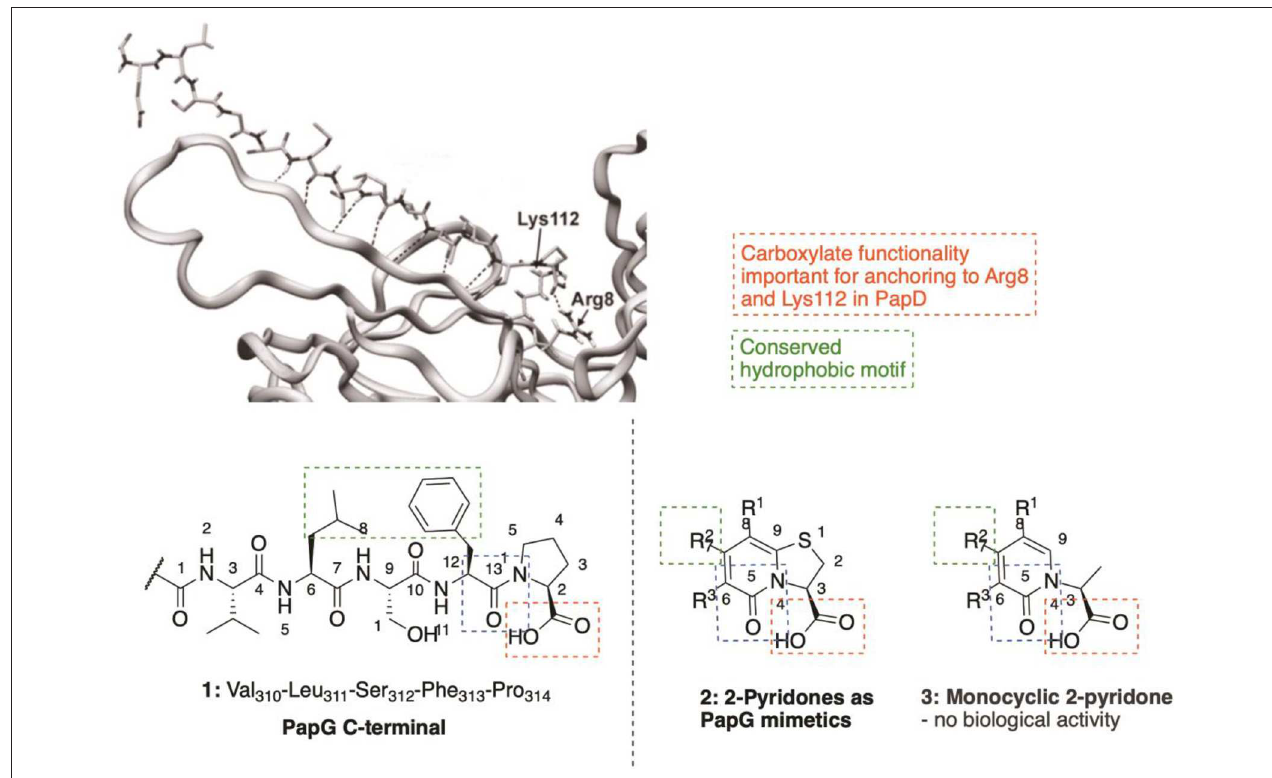
FIGURE 2 | The two final amino acids (Phe 313 -Pro 314 ) in the C-terminal of PapG bound to PapD served as template for design of the pilicide scaffold that inhibit pilus